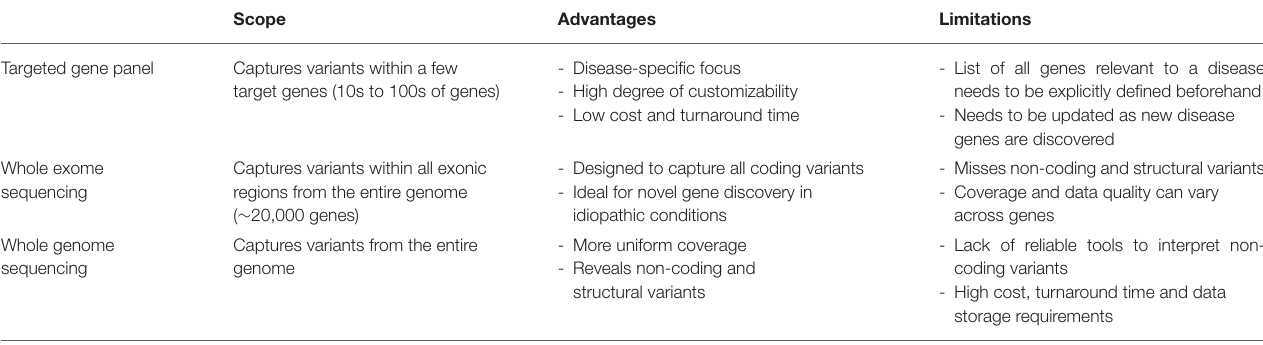
TABLE 3 | Current primary technologies for detecting human genetic